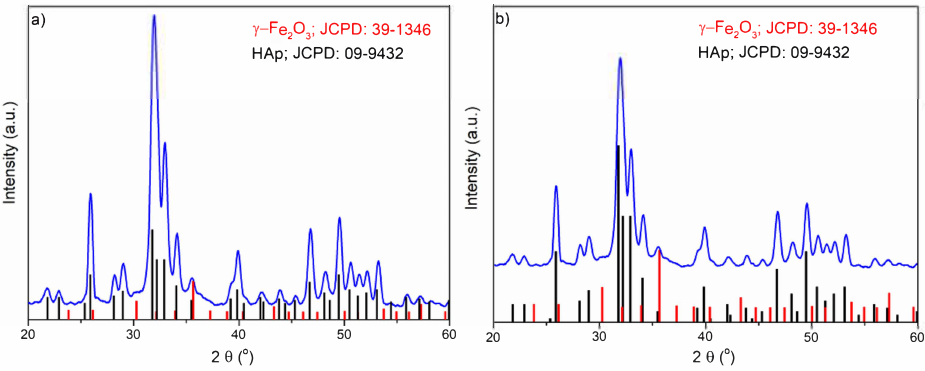
Figure 3. The XRD patterns of iron-doped hydroxyapatite (HApFe) (blue) powder ( a ) and coatings ( b ) and reference patterns for (black) HAp PDF #09-9434 and (red) Fe 2 O 3 PDF #